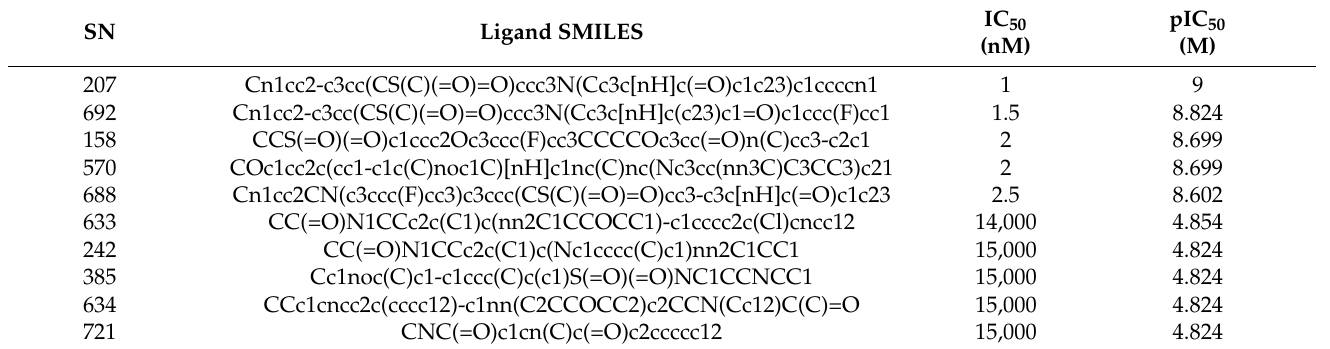
Table 2. SMILES notation and IC 50 (nM) and pIC 50 (M) of five most and least active molecules of the selected data set.